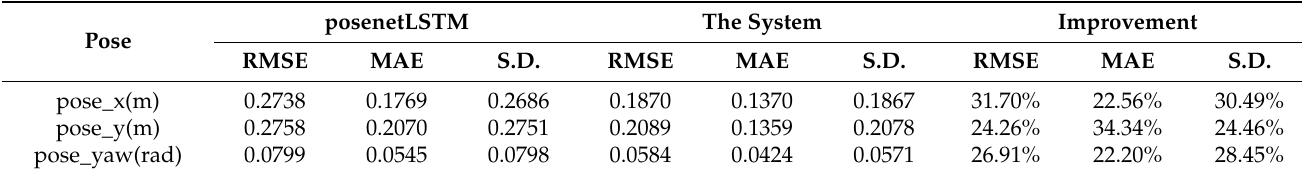
Table 4. The results of the pose estimation errors in the x , y , and yaw directions, respectively.